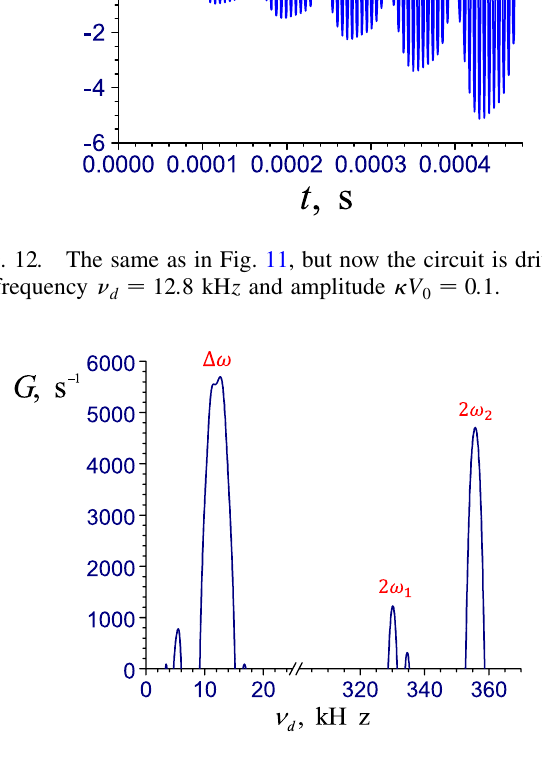
FIG. 13. Gain per unit time as a function of the driving for the drive amplitude (cid:10)V 0 ¼ 0 : 1 . The circuit frequency (cid:3) d parameters are given by Eqs. (E5) and